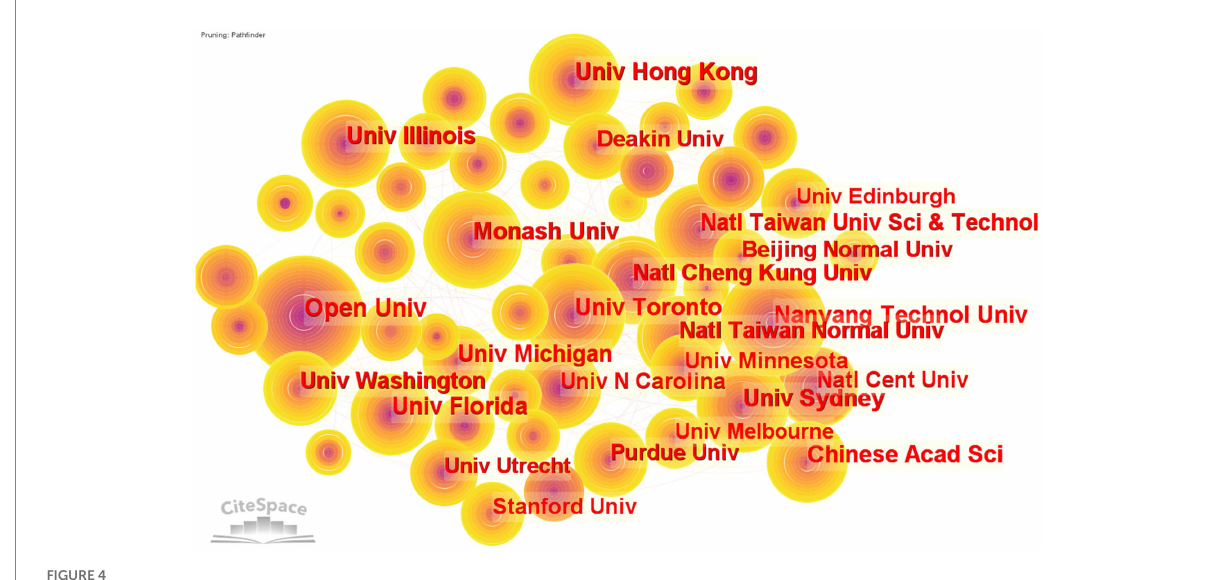
FIGURE 4 Visualization of the institution collaboration